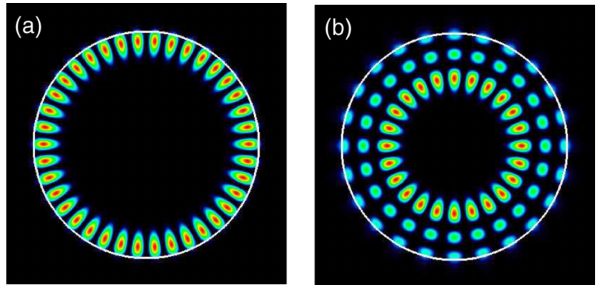
Figure 23. Whispering-gallery modes (WGMs) in a dielectric microdisk. The refractive index of GaAs is n = 3.3, and the polarization is TM. The different numbers are (for more details (see [61])): ( a ) l = 1 and m = 19; ( b ) l = 3 and m = 12, reprinted figure with permission from [61], Copyright (2015) by the American Physical